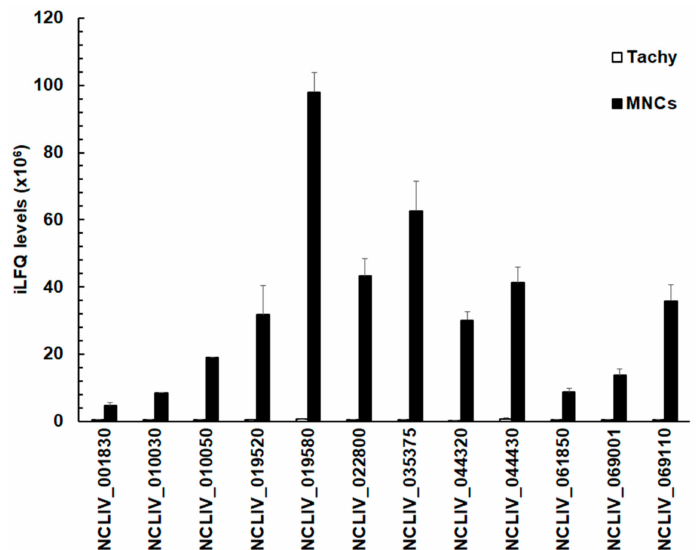
Figure 3. Quantitative assessments of the proteins in tachyzoites (Tachy, white bars) and MNCs (MNCs, black bars) listed in Table 3. For all proteins, mean values ± one standard deviation for LFQ intensities ( × 10 6 ) in three biological replicates are shown. The proteins are termed by their respective accession numbers in the